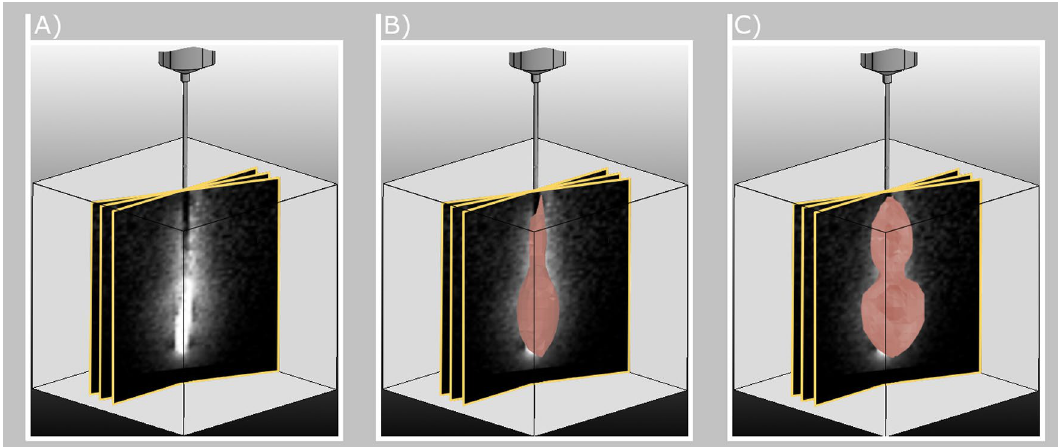
Figure 3. ( A ) Uniformly distributed thermometry maps around the main axis of the applicator. Only three slices are shown as examples. ( B ) 3D simulation (red volume) fitting using a least-square norm estimation (t